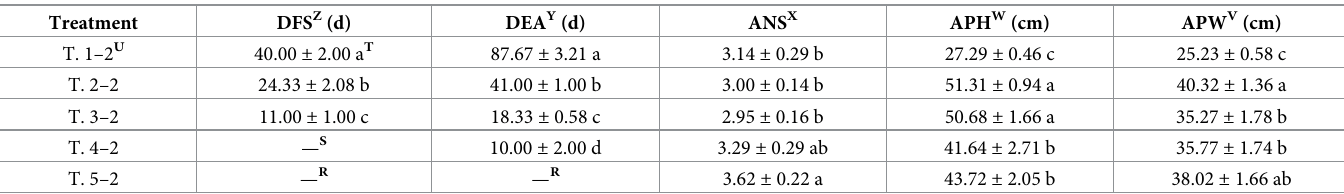
Fig 9. Sprouting and growth of potted ‘Hang Baishao’ plants in Experiment I. (A): natural low temperature + 5-azacytidine; (B): natural low temperature + GA 3 ; (C): natural low temperature + 5-azacytidine + GA 3 .